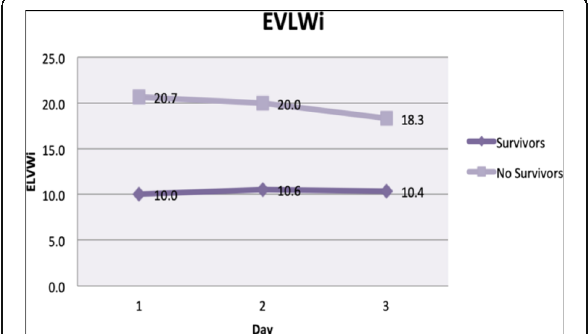
Fig. 2 (abstract 001048). See text for description.